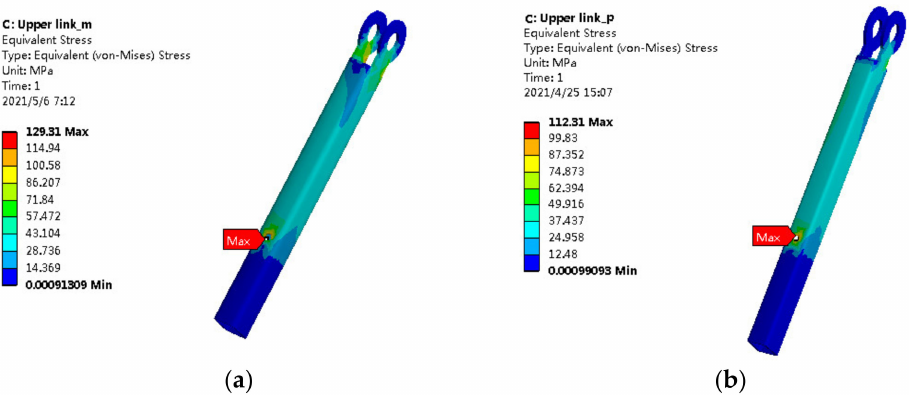
Figure 19. Stress distribution of upper connecting rod of tensioner support. ( a ) Scaled model; ( b ) prototype.